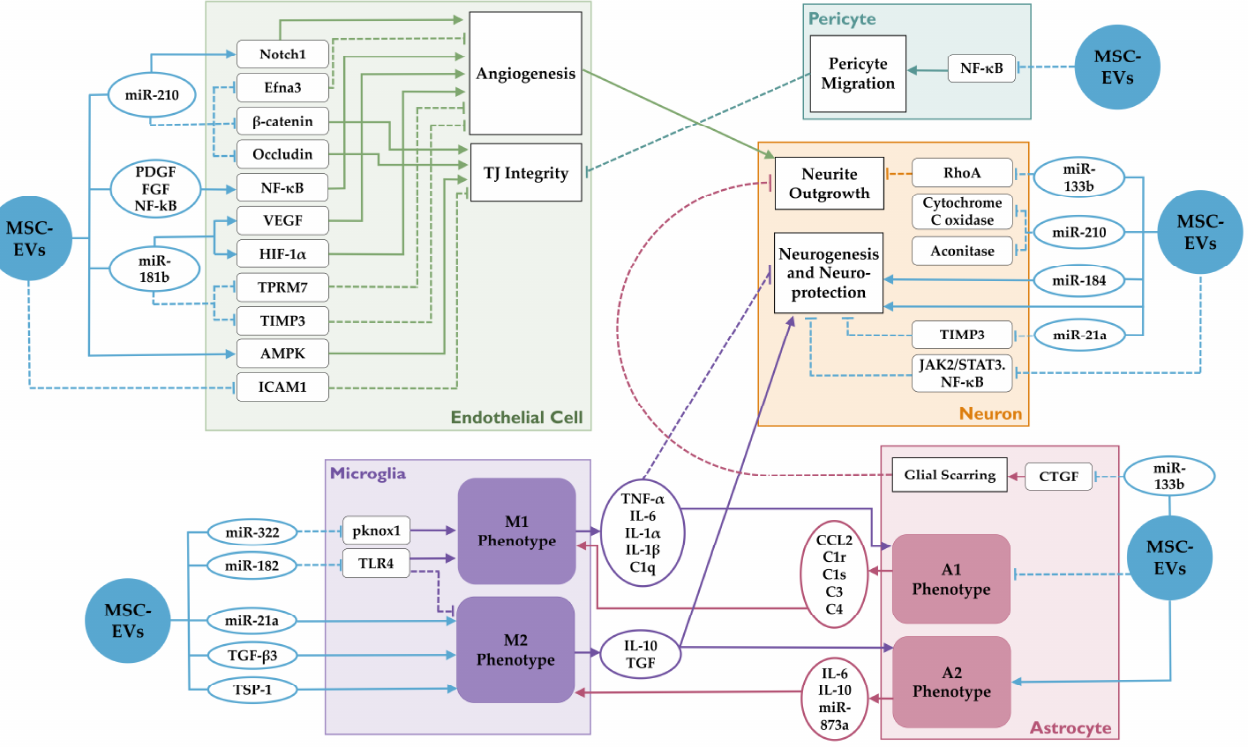
Figure 1. Molecular effects of MSC-EVs on various cells in the neurovascular unit (NVU) in stroke. MSC-EVs and its contents affect diverse molecular pathways in endothelial cells, microglia, astrocytes, neurons and pericytes. They regulate various processes such as angiogenesis, tight junction integrity, pericyte migration, neurite outgrowth, neurogenesis, and microgial polarization. These complex interactions between different cell types determine the neurological outcome after stroke. Dotted lines indicate inhibition, while solid lines indicate potentiation.